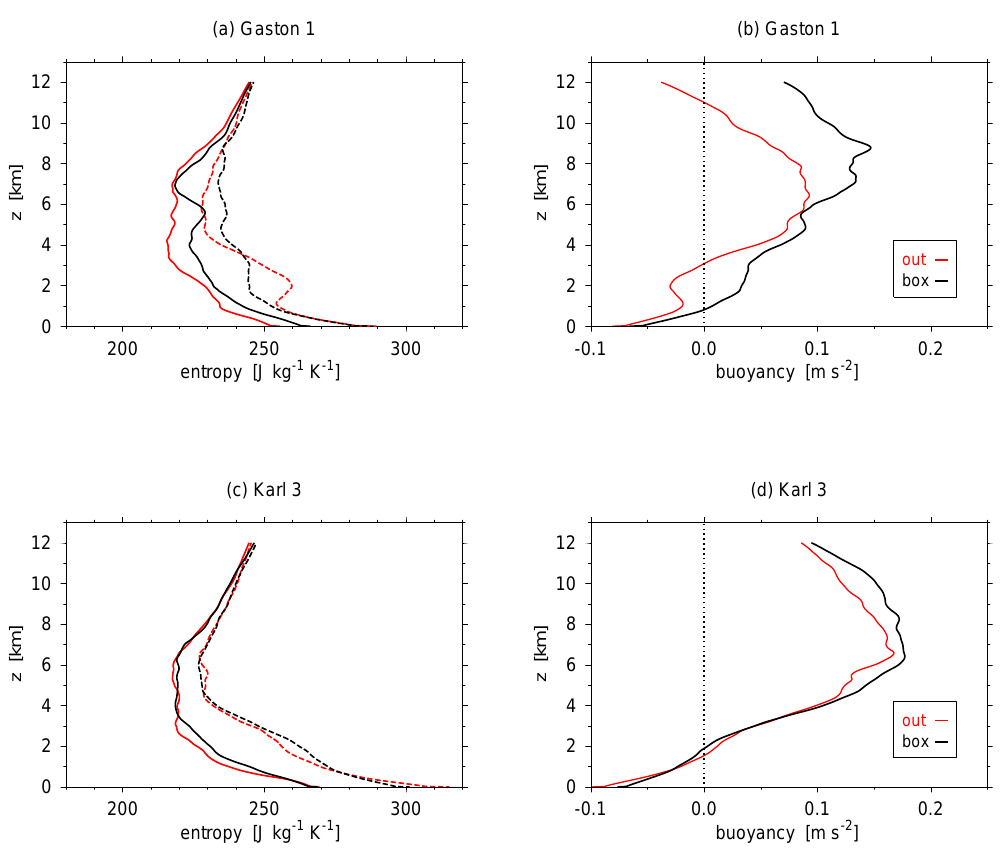
Fig. 10. Vertical profiles of (a) moist entropy (solid lines) and saturated moist entropy (dashed lines) for Gaston 1, (b) buoyancy for Gaston 1, (c) moist entropy (solid lines) and saturated moist entropy (dashed lines) for Karl 3, and (d) buoyancy for Karl 3. The black lines represent averages over the dropsondes inside the respective black box in Fig. 8, and the red lines represent averages over the dropsondes enclosed with the respective red box, but outside of the black box in Fig. 8.